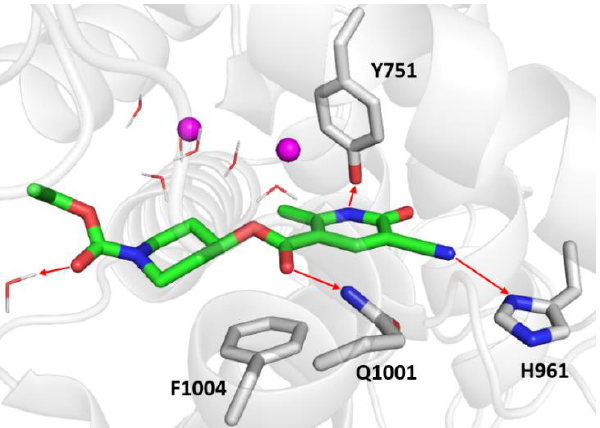
Figure 6. Zoomed in view of the PDE3A binding site. DF492is rendered as green sticks in the representation, the most relevant residues are reported as gray sticks, the magnesium ions are indicated as violet spheres, and the water molecules are depicted as wireframes. The red arrows indicate the hydrogen bonds.